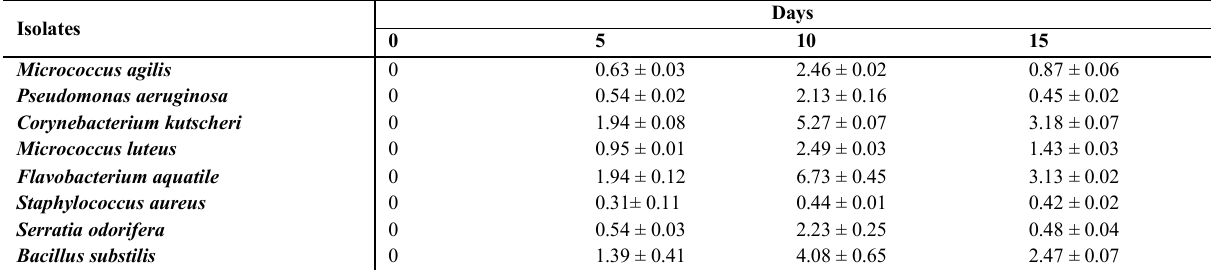
Table 6: Total viable count (TVC) of bacterial isolates during growth in hydrocarbon medium (x 108 CFU/ml). Isolates